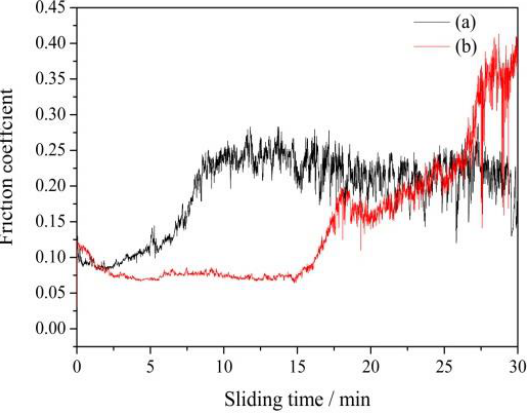
Figure 9. Friction coefficient vs. sliding time of (a) the top of the gradient remelted layer (M1) and (b) the position where the hardness was two-thirds of the top of the remelting layer (M2).